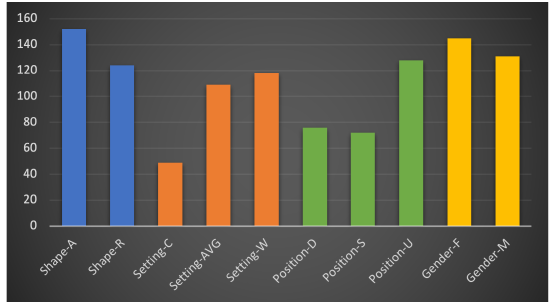
Figure 3. Distribution of attributes over 276 subject.